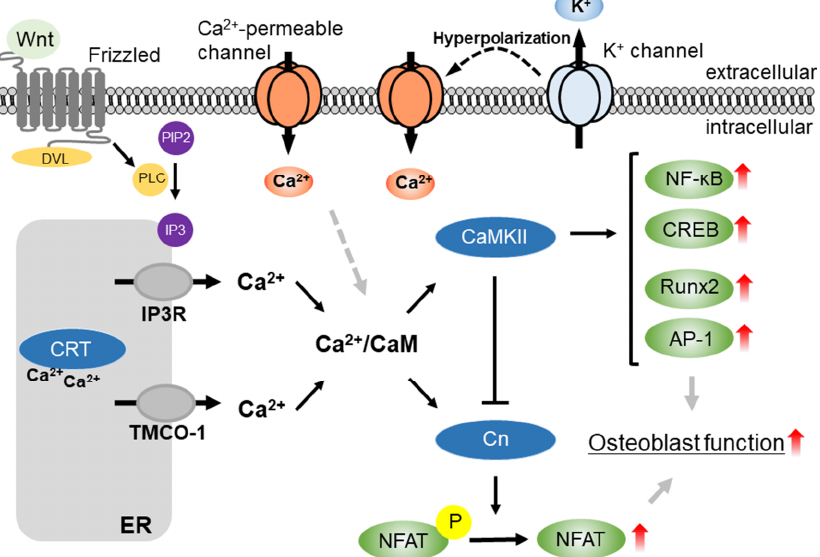
Figure 1. The Wnt/Ca 2+ signaling is initiated when Wnt ligands bind to the Frizzled receptor. Then, the Disheveled (DVL) is recruited and activates phospholipase C (PLC), leading to Ca 2+ re- lease. Calreticulin (CRT) is a Ca 2+ -binding multifunctional molecular chaperone in the endoplasmic reticulum (ER). CRT is involved in IP 3 -mediated Ca 2+ release from ER. [Ca 2+ ] i increase via IP 3 R, transmembrane, and coiled-coil domains 1 (TMCO-1), and Ca 2+ -permeable channels cause calmod- ulin (CaM) activation. The Ca 2+ /CaM complex regulates Ca 2+ /CaM-dependent protein kinase and phosphatase such as CaMKII and calcineurin (Cn). These Ca 2+ -dependent signalings induce the activation of transcriptional factors, including the nuclear factor of activated T cells (NFAT), nuclear factor-kappa B (NF- κ B), cAMP response element-binding protein (CREB), Runt-related transcription factor 2 (Runx2), and activation protein 1 (AP-1), leading to the osteoblast